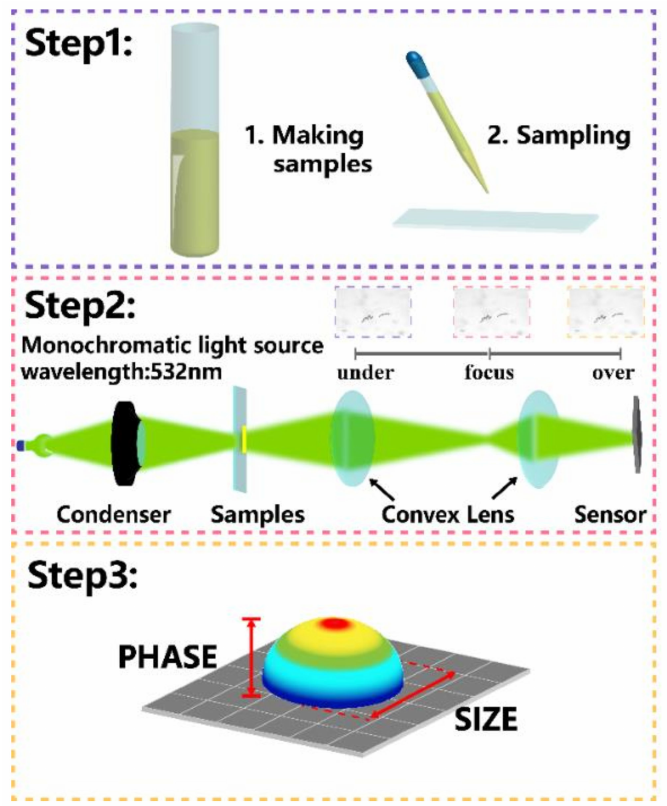
Figure 3. Experimental process. Step 1: Marking of samples and sampling. Step 2: Observation and collection of images. Step 3: Phase